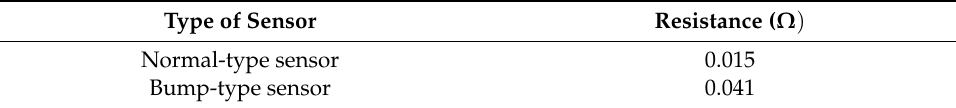
Table 5. Theoretical resistance of the EGaIn soft sensors.